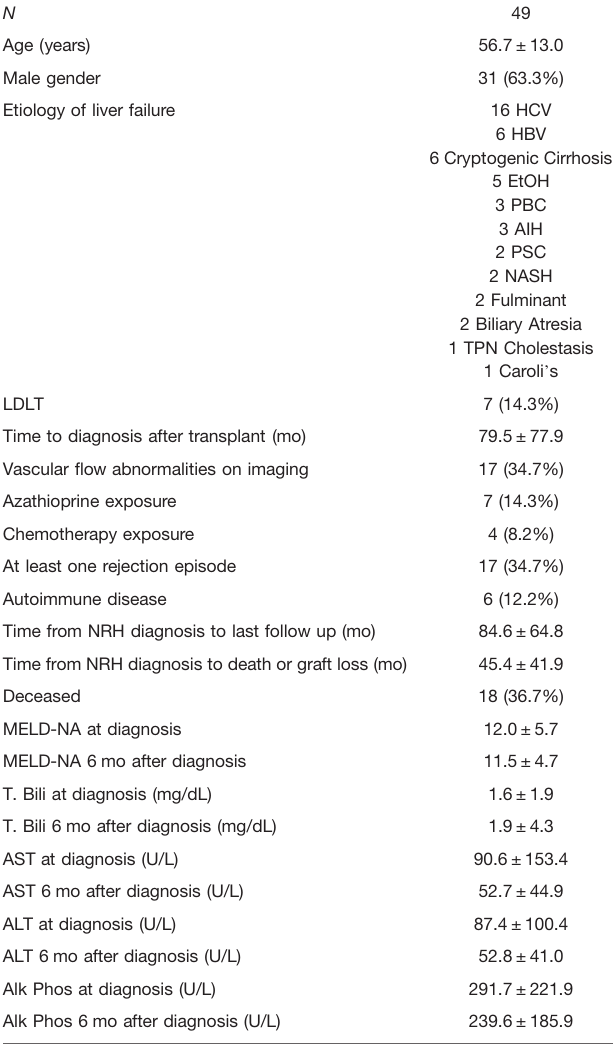
TABLE 1 | Patient